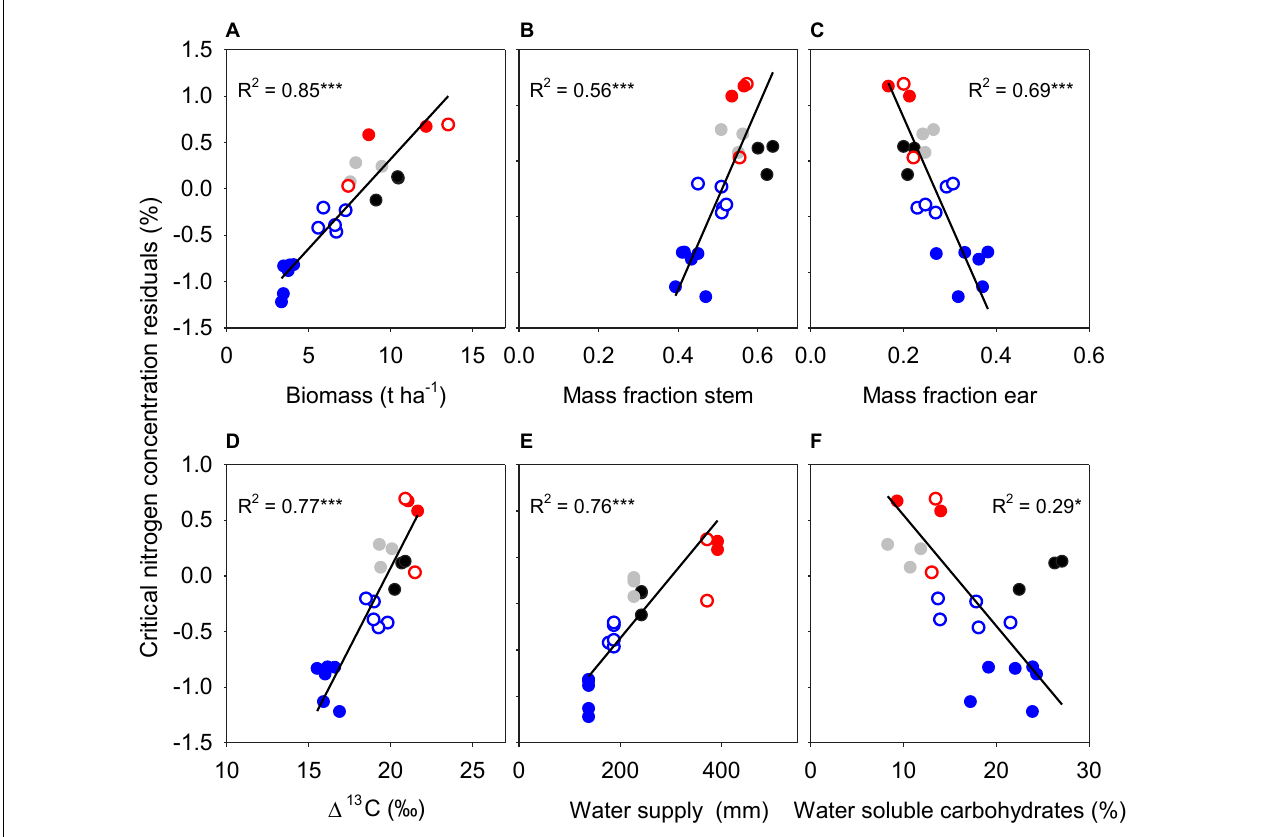
FIGURE 6 | Residuals from the critical nitrogen concentration vs. biomass model at anthesis in relation to (A) biomass, (B) mass fraction stem, (C) mass fraction ear, (D) (cid:49) 13 , (E) water supply, and (F) water-soluble carbohydrates in stem. Lines are Model II regressions, with ∗∗∗ P < 0.001, ∗ P < 0.05. Symbols: Hart 2014 rainfed (black); Turretfield 2014 rainfed (gray); Roseworthy 2015 rainfed (filled blue); Roseworthy 2015 irrigated (open blue); Roseworthy 2016 rainfed (filled red); Roseworthy 2016 irrigated (open